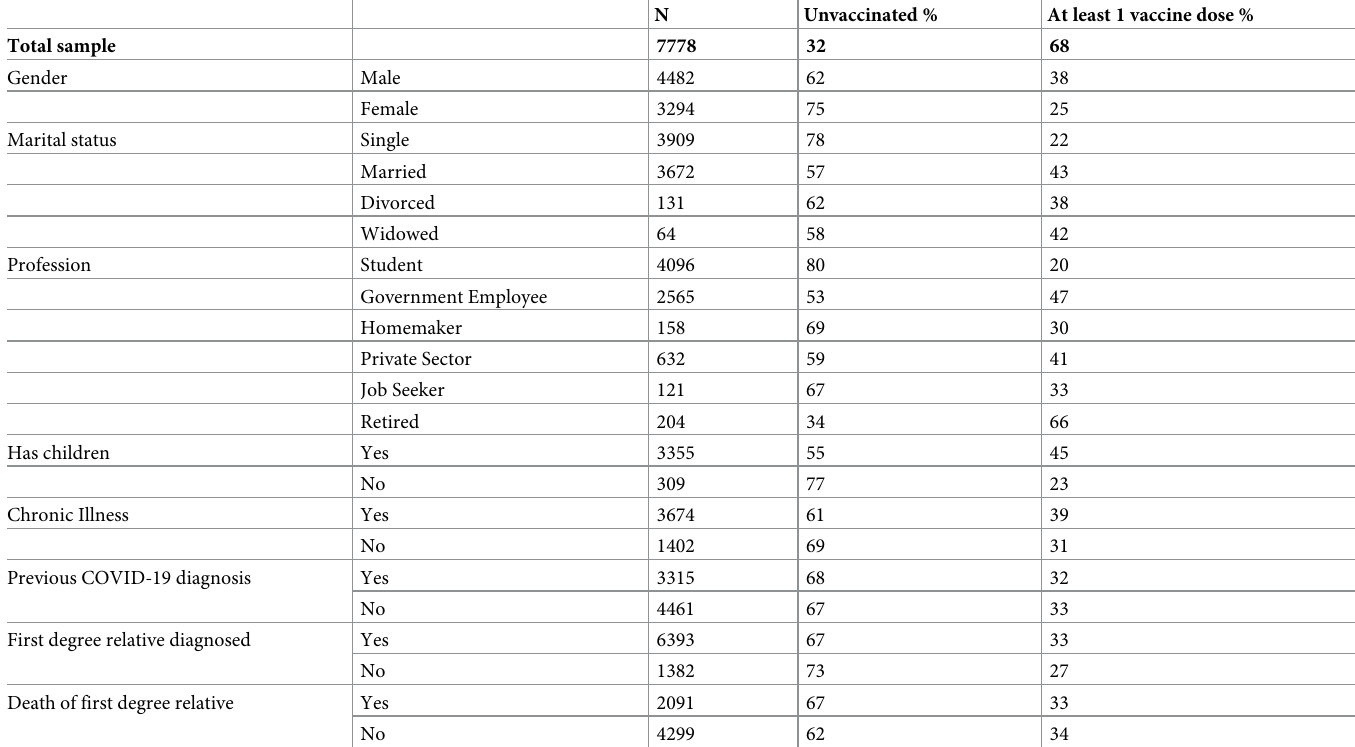
Table 1. Vaccination rates (%) as a function of demographic